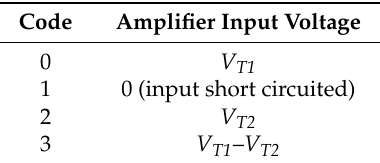
Table 1. Amplifier input differential voltages as a function of the connection-matrix control